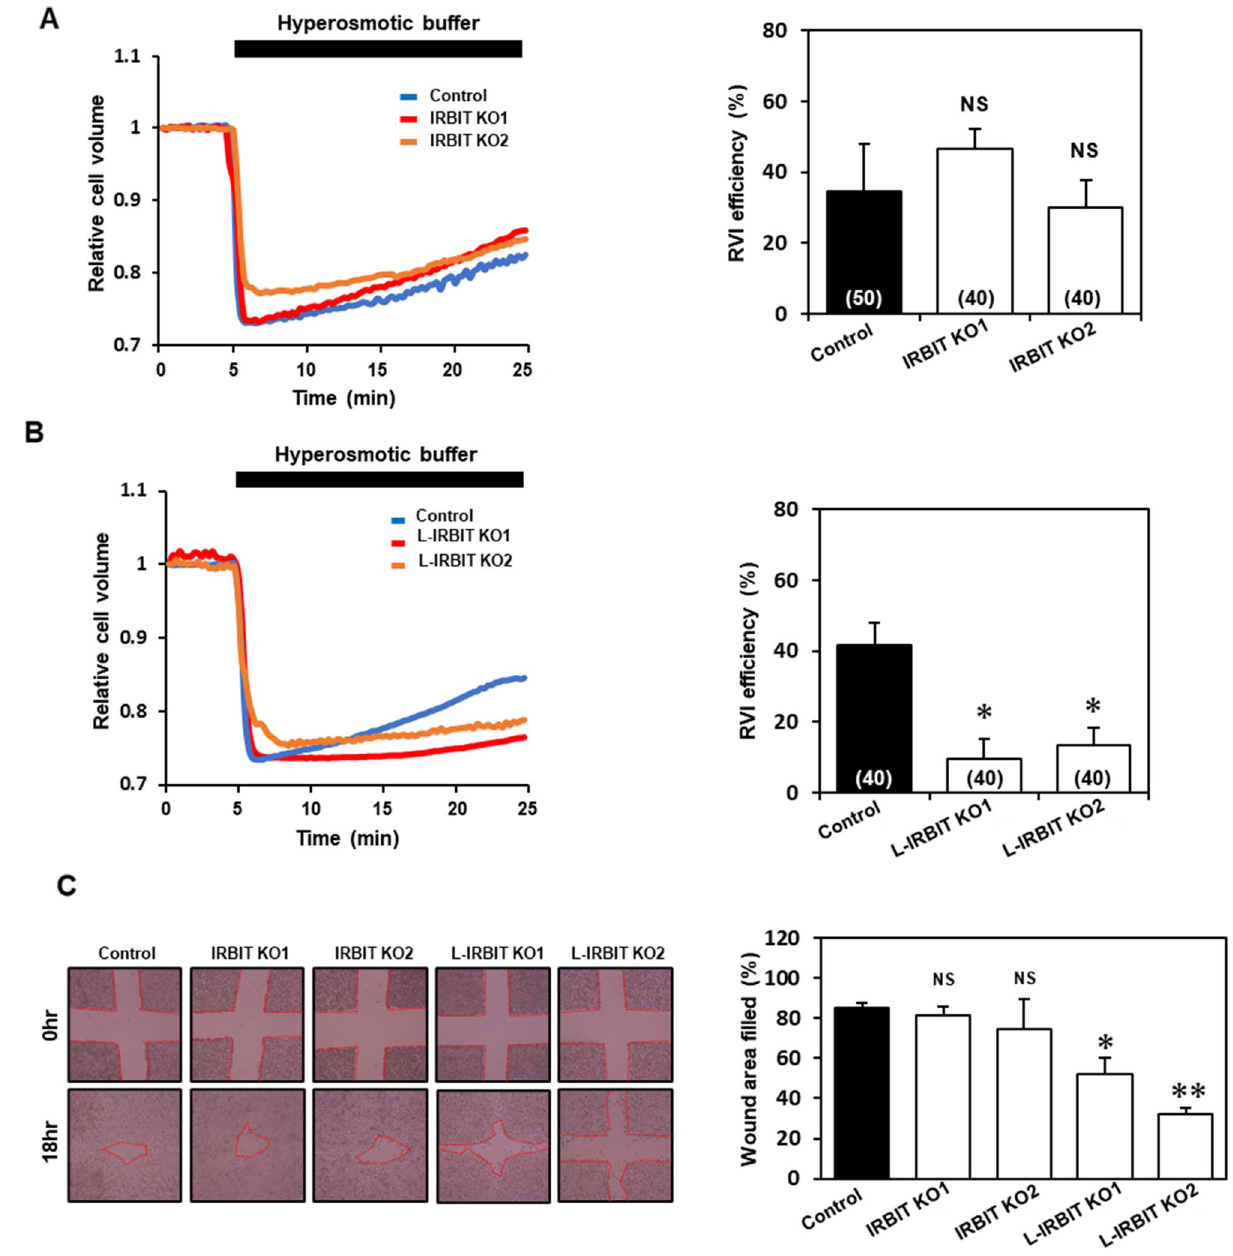
Figure 3. Cell volume recovery after hypertonic stress is impaired in L-IRBIT knockout cells. ( A ) Cell volume recovery in IRBIT KO cells was measured based on the fluorescence change upon changing the perfusion buffer from a 300 mOsm buffer to a 450 mOsm buffer using calcein-AM. Representative plots of the relative cell volume change compared with a baseline obtained from the control (blue), IRBIT KO1 (red), and IRBIT KO2 (orange) (left panel). RVI efficiency of each cell type at 20 min after replacing the buffer with a 450 mOsm buffer. RVI efficiency (%) was 34.6 ± 13.6 (WT), 46.7 ± 5.6 (IRBIT KO1), 30.0 ± 7.7 (IRBIT KO2), N = 3–4 (right panel). ( B ) Cell volume recovery in L-IRBIT KO cells was measured as above. A representative plot of the relative cell volume from control (blue), L-IRBIT KO1 (red), and L-IRBIT KO2 (orange) (left panel). RVI efficiency of each cell type was 41.8 ± 6.1 (WT), 9.7 ± 5.6 (L-IRBIT KO1), 13.3 ± 5.0 (L-IRBIT KO2). N = 3—4 (right panel). ( C ) The results of the wound healing assay were shown. Representative photomicrographs of the wounded cell monolayer are shown (left panel). Wound width was measured in 6 positions immediately after wounding and 18 h later in WT, IRBIT KO (IRBIT KO1, IRBIT KO2) and L-IRBIT KO (L-IRBIT KO1, L-IRBIT KO2), N = 4 (right panel). The total cell numbers were indicated in each graph. * P < 0.05, ** P < 0.01, NS (no